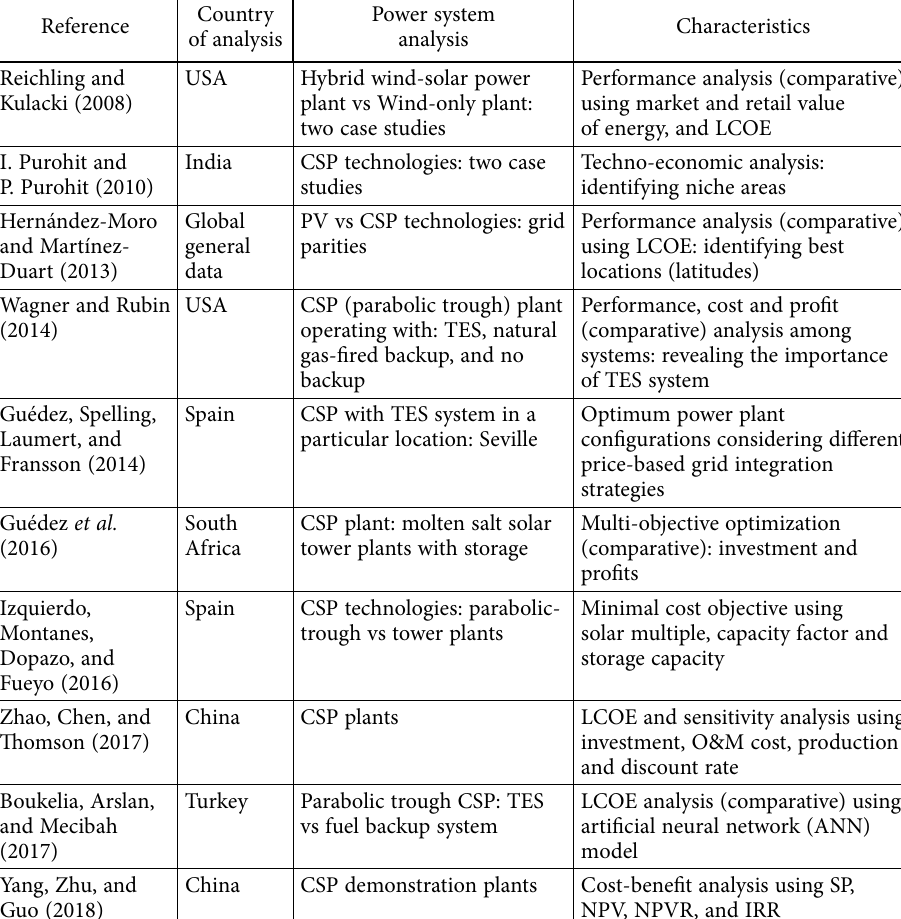
Table 1. Empirical research on the cost structure of CSP system